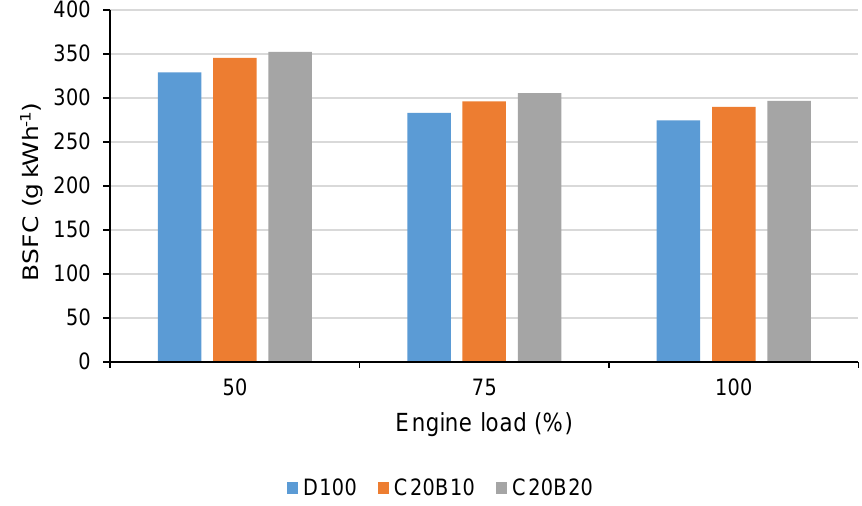
Figure 10. Brake specific fuel consumption (BSFC) in relation to engine load for all tested fuels.